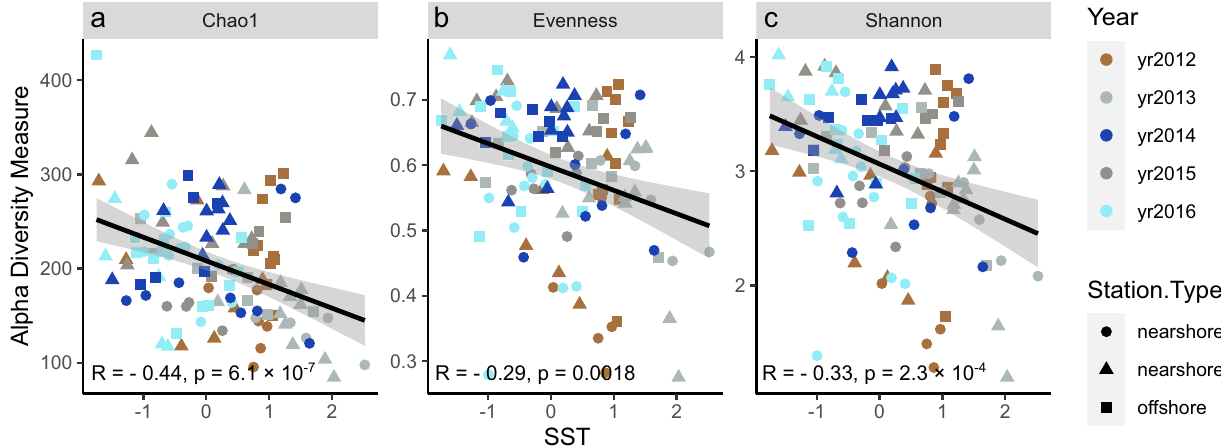
Fig. 4 Alpha diversity indices vs. SST. Three diversity indices, including Chao1 ( a ), Pielou ’ s evenness ( b ), and Shannon ( c ), plotted against SST, with year indicated by color and station type indicated by shape. Reads from each sample were rare fi ed to an even depth. Solid red lines represent linear fi ttings and the gray bands represent 95% con fi dence intervals. All three diversity indices show signi fi cant negative correlations with SST (two-sided t-test, p < 0.01). Source data are provided as a Source Data fi